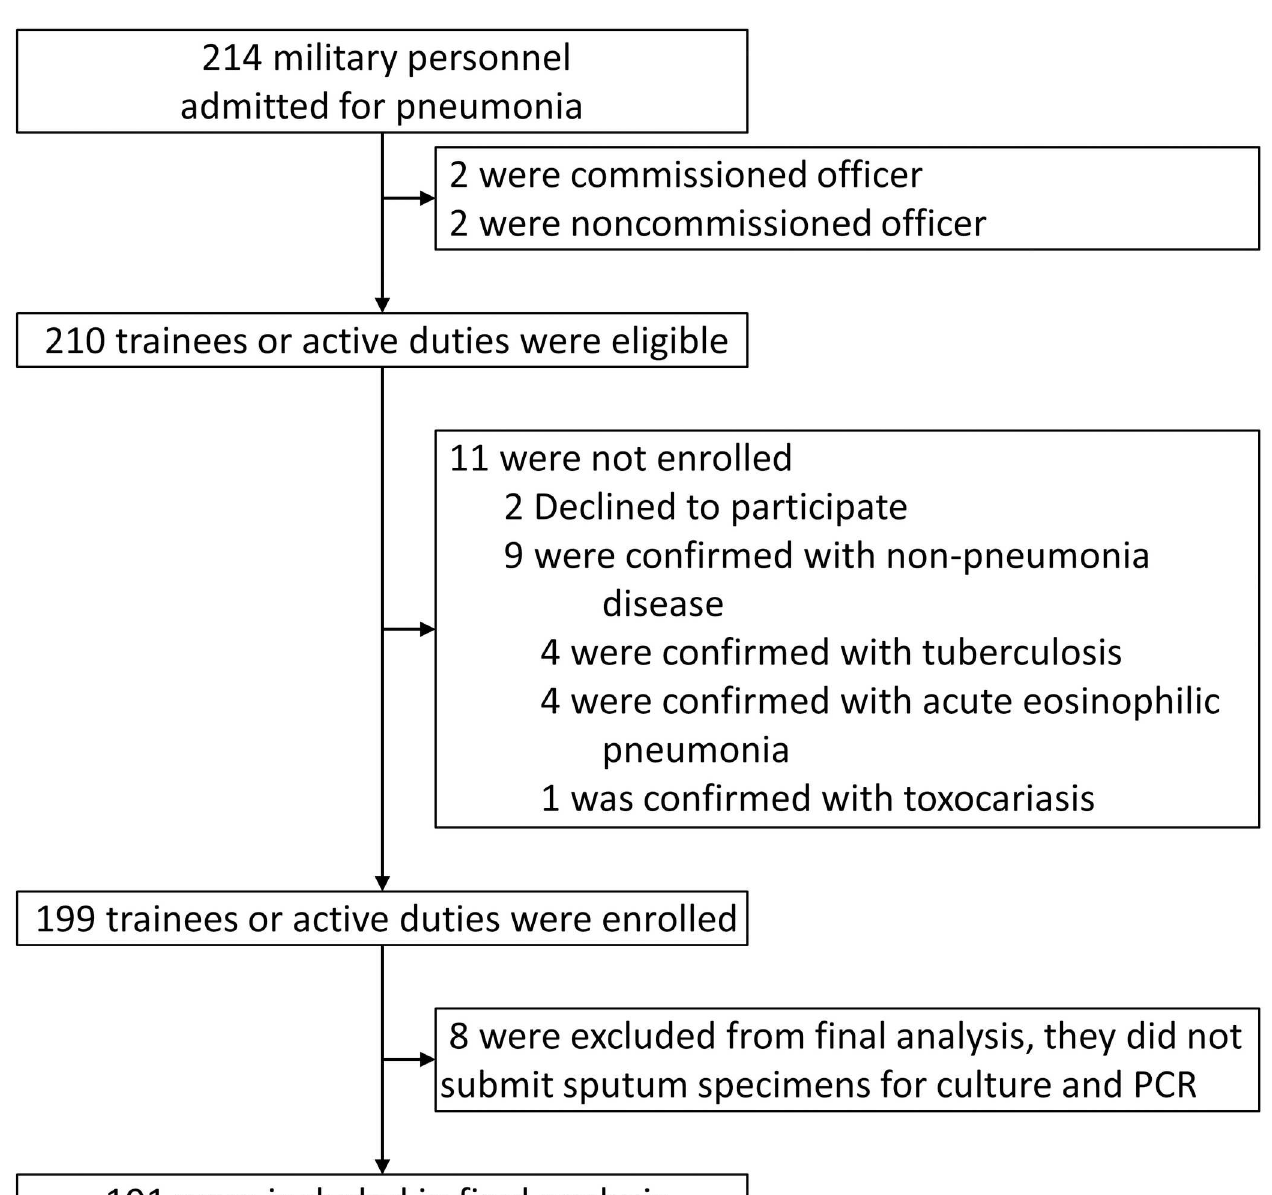
Fig 1. Enrollment of patients with community acquired pneumonia in the Korean